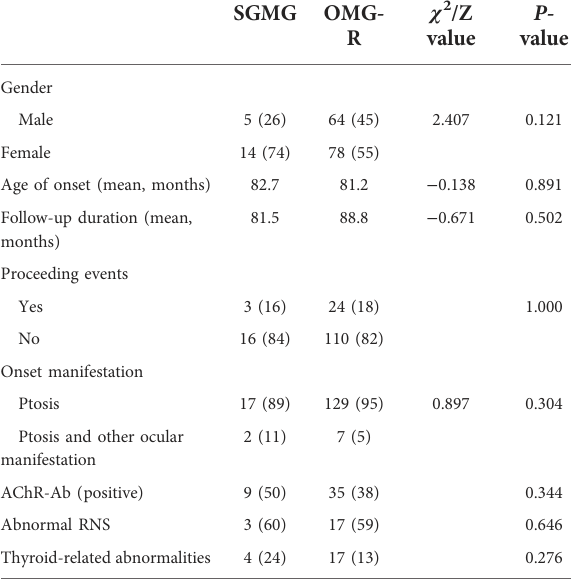
TABLE 3 Comparison of clinical characteristics between cases that remained with ocular myasthenia gravis with secondary generalized myasthenia